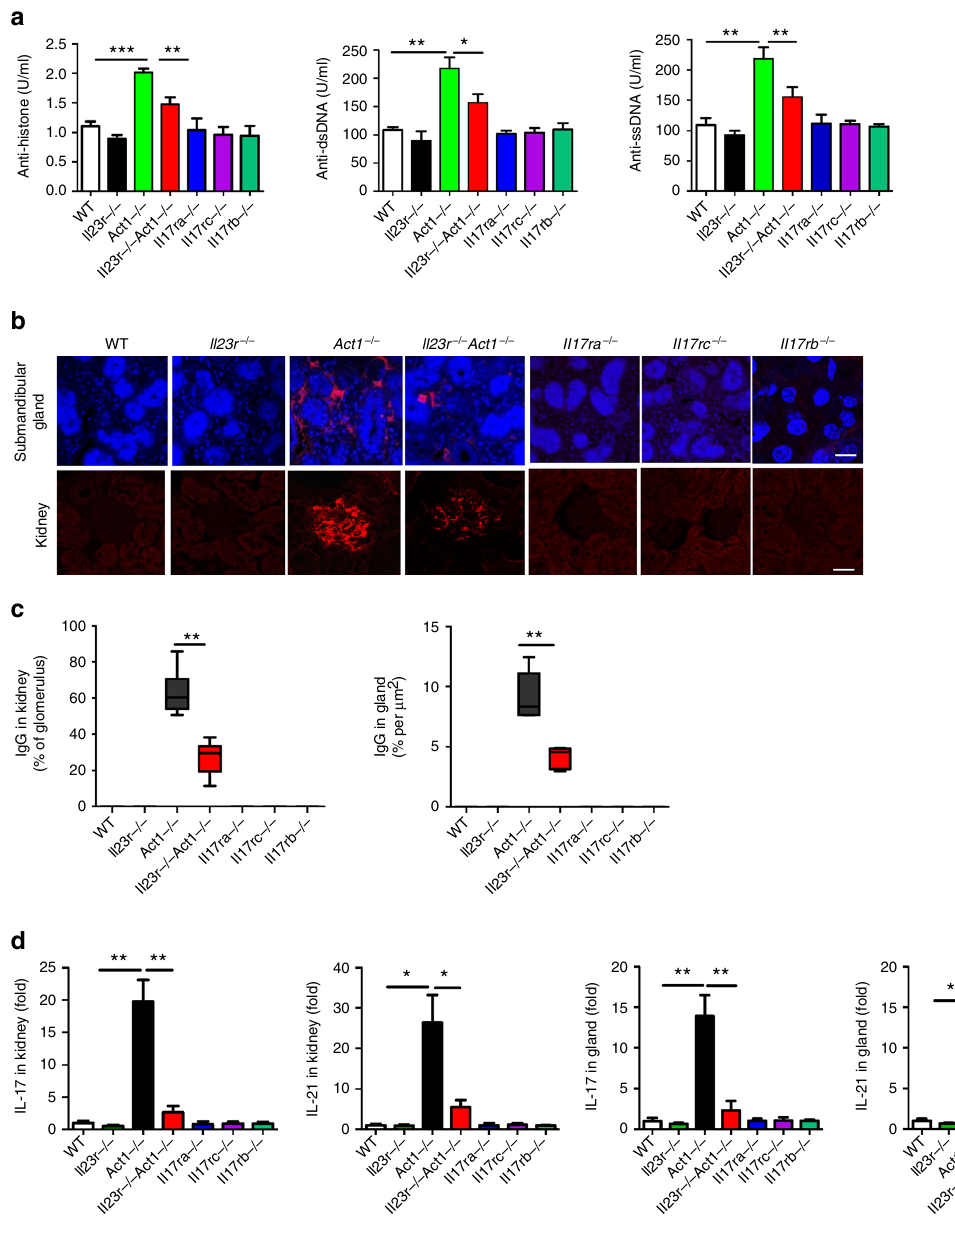
Fig. 3 IL-23R is required for the autoimmune diseases in Act1 − / − mice. a Serum samples were obtained from 8-month-old mice with indicated phenotypes and analyzed for levels of anti-histone, anti-dsDNA, and anti-ssDNA lgG. b Kidneys and submandibular glands were harvested and quick frozen in OCT, followed by immuno fl uorescence staining for IgG (red). Scale bars, 50 µ m. c Quanti fi cation of lgG deposit in glomerulus of kidney and submandibular gland. d RT-PCR analysis of IL-17 and IL-21 transcripts in submandibular gland and kidney from 8-month-old mice with indicated genotypes. N = 4 – 6/group. Mean± SEM. * p < 0.05; ** p < 0.01; *** p < 0.001; Two-tailed Student ’ s T test. All the data presented were from two independent experiments